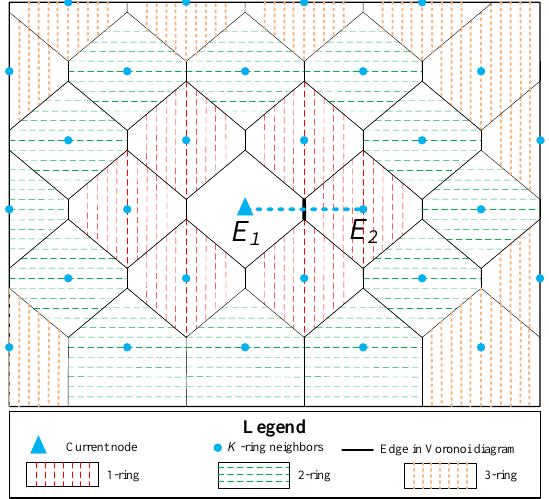
Figure 2. Voronoi diagram.